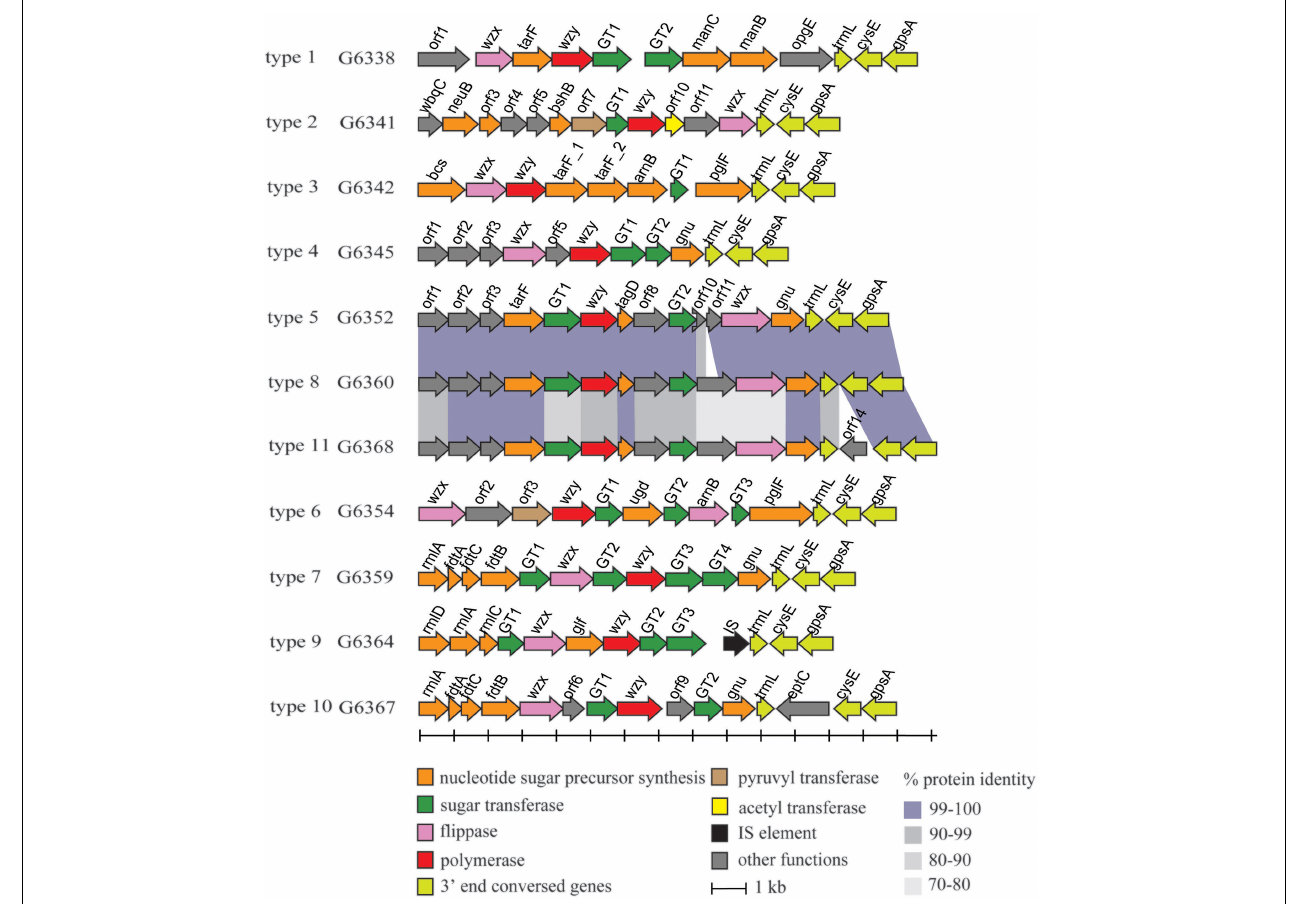
FIGURE 1 | Schematic diagram of the 11 putative O-AGCs characterized from the 27 M. morganii strains. Genes are represented by arrows and colored according to the gene key at the bottom. TABLE 3 | Homologous and heterologous agglutinin titers of antisera before absorption. Antiserum to